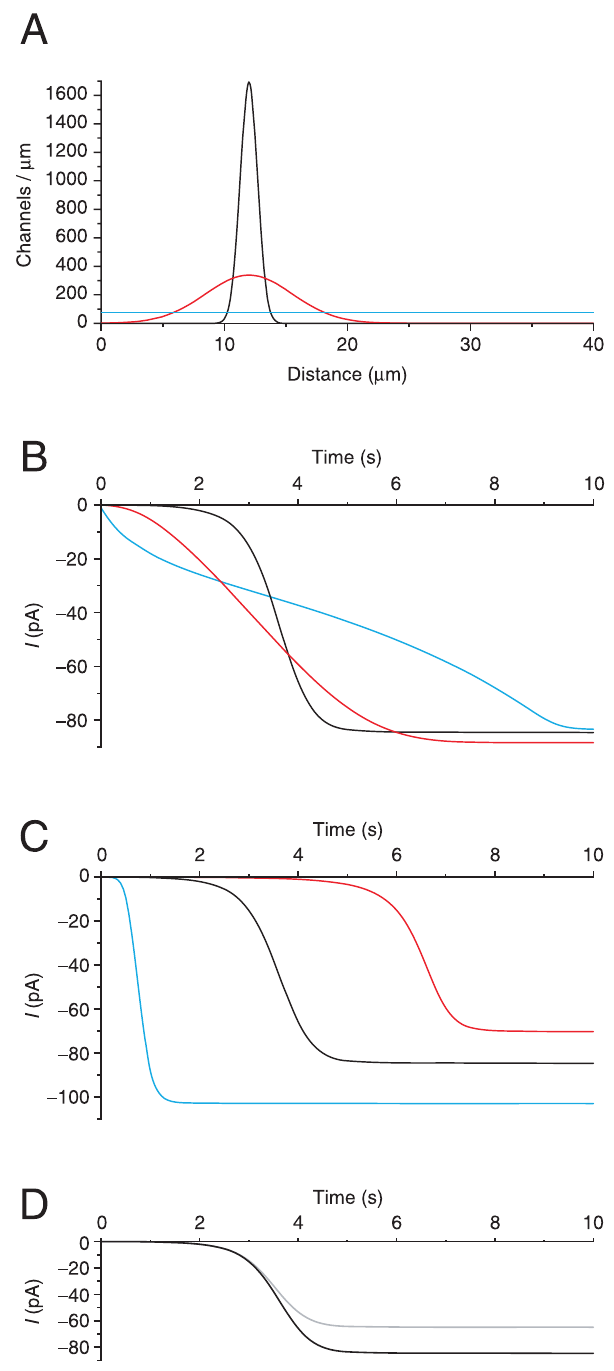
Figure 3. Currents predicted by the forward model for various assumed channel distributions. A hypothetical cilium was assumed to be 40 m m long with 3000 Ca 2 + -gated Cl 2 channels distributed along its length. The forward model was used to predict the current as a function of time assuming the cilium was placed in a bath containing 2 mM BAPTA and 300 m M free Ca 2 + with the pipette potential clamped at 2 50 mV. (A) Three assumed channel distributions are shown. The blue line shows a uniform distribution. The others show the channels distributed as Gaussian bands. The widths of the bands at points where the height is 10% of the peak height are 3 m m (black) and 15 m m (red). (These correspond to d w =1 and d w =5 using the terminology defined in Text S1.) Each of these two bands was centered at a distance of 12 m m from the base of the cilium. (B) The predicted currents assuming